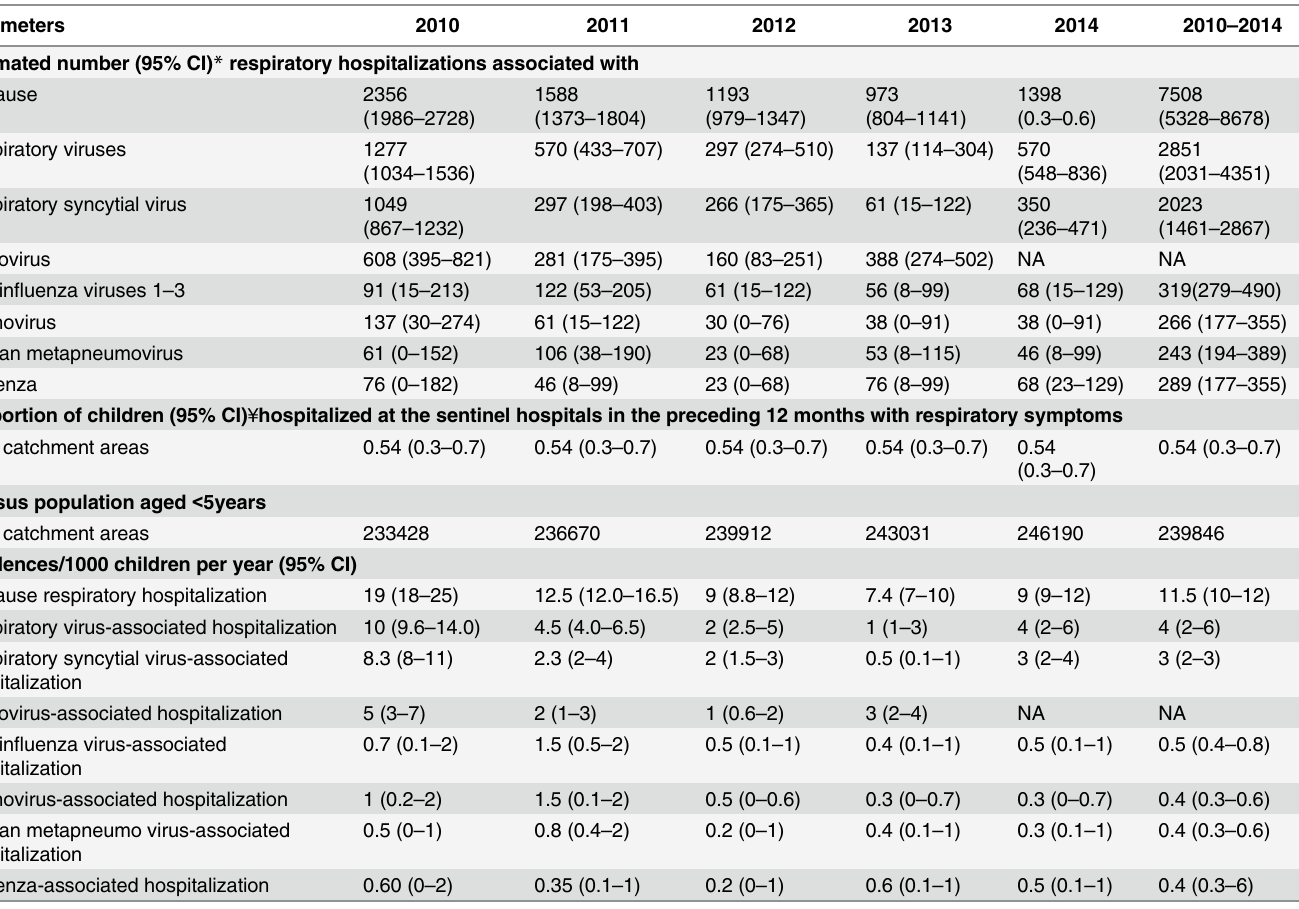
Table 2. The incidences of respiratory viral pathogen specific hospitalized respiratory illness (per 1000 children per year) among children aged < 5years in four surveillance hospitals, Bangladesh, 2010 –